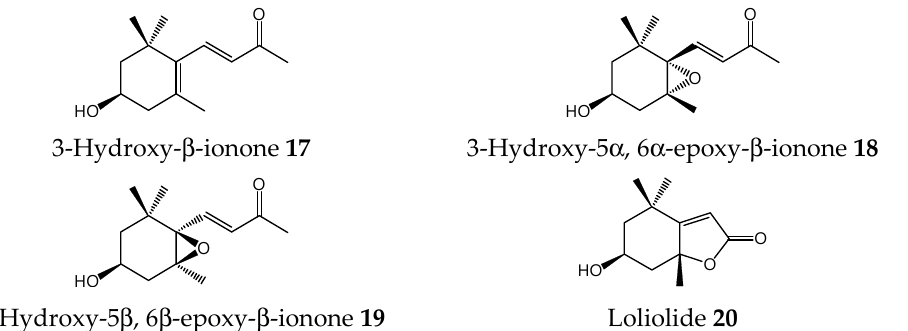
Figure 6. Compounds isolated from allelopathic subfractions E13F2-E13F4 of S. platensis . Dihydroactinidiolide 10 , colorless oil, 9.6 mg (0.027% from crude ethyl acetate extract); 1 H NMR (CDCl 3 ) 1.22 (3H, s , H-9), 1.27 (3H, s , H-10), 1.22–1.34 (1H, m , H-2 α ), 1.46 (1H, m ,